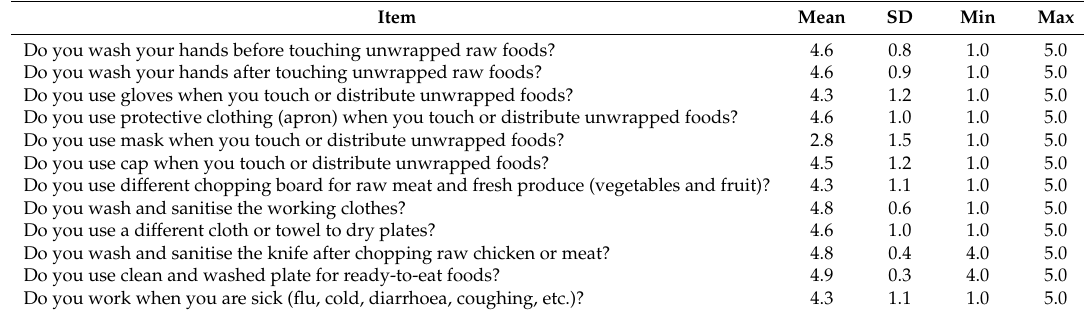
Table 3. Participant self-reported food safety